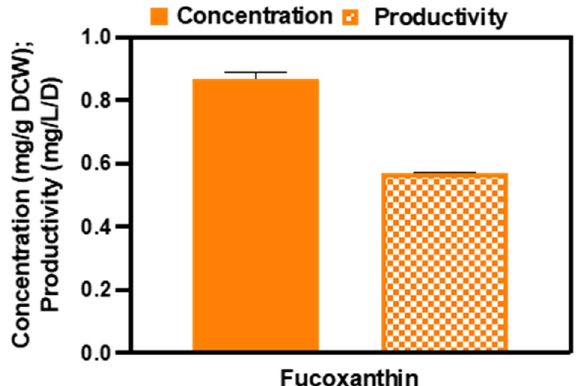
Figure 4. Fucoxanthin concentration (mg/g DCW) and productivity (mg/L d) in C. cryptica cultivated in